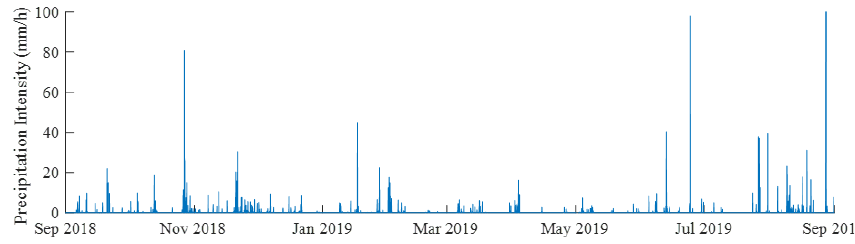
Figure 2. Precipitation intensity during the measurement period.